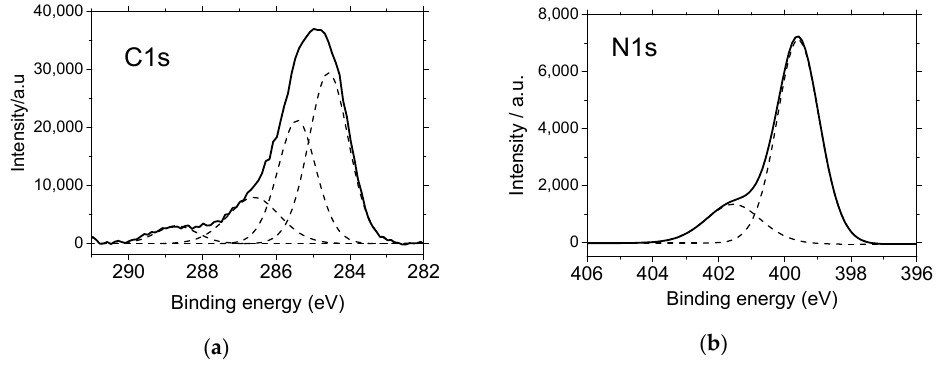
Figure 6. Deconvoluted ( a ) C 1s and ( b ) N 1s X-ray photoelectron spectroscopy (XPS) core-level spectra